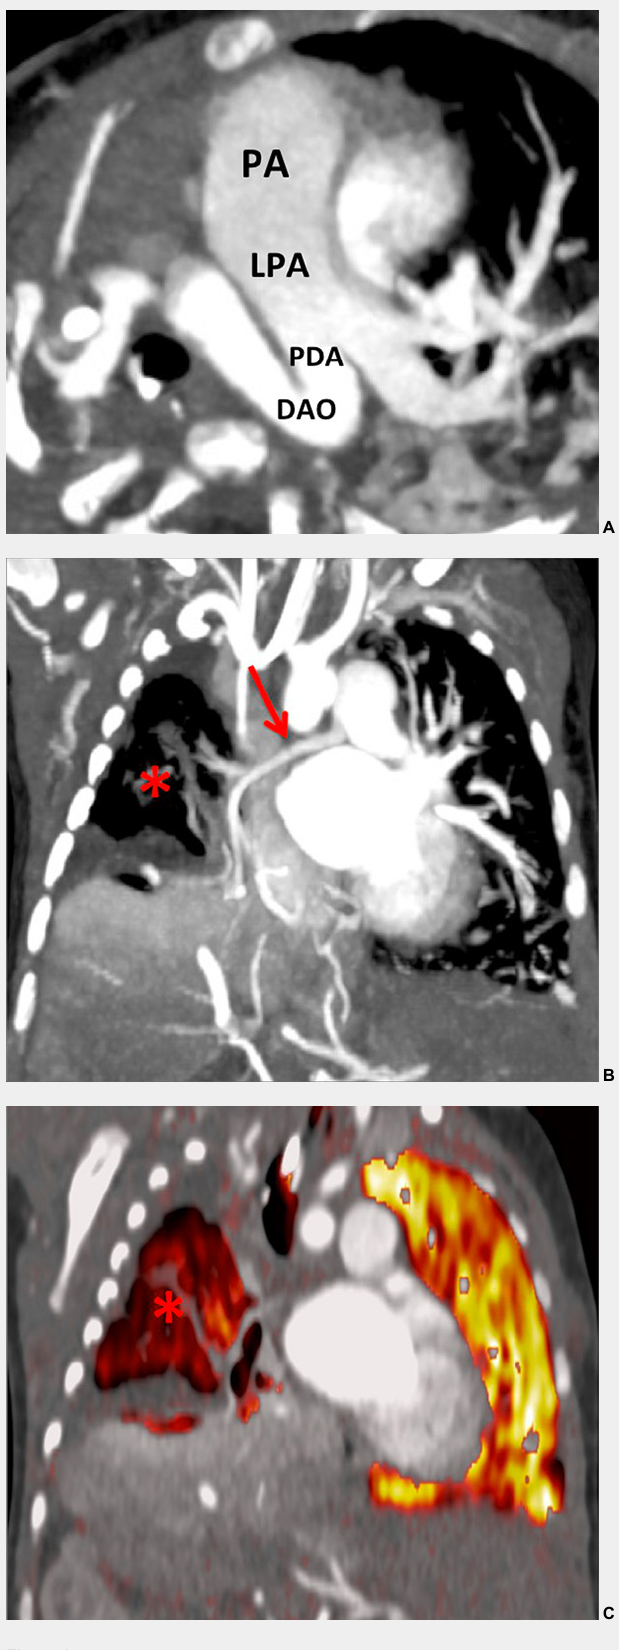
Figure 9 Pulmonary hypertension due to a patent ductus arteriosus (PDA) connecting the descending aorta (DAO) to the left pulmonary artery (LPA) ( A ) in a 2-month-old boy treated for a right diaphragmatic hernia ( B ) resulting in hypoplasia of the right pulmonary artery (arrow). The functional consequences ( C ) are extended hypoperfusion of the right lung